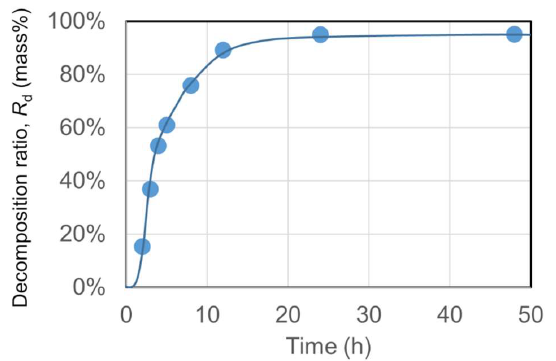
Figure 2. Decomposition ratio of resin in CFRP specimen immersed in 8 M of HNO 3 at 80 °C.